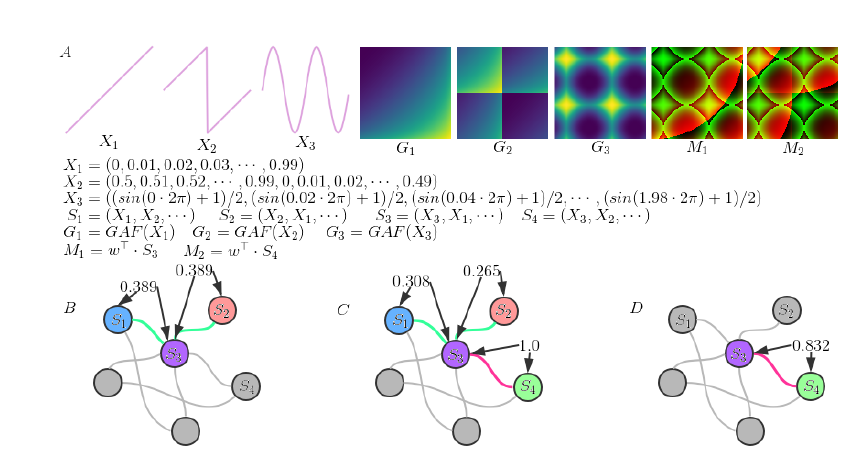
Figure 2. Correlation of time series and images. ( A ) X 1 , X 2 and X 3 represent different time series; G 1 , G 2 and G 3 are GAF images converted from the time series X 1 , X 2 and X 3 , respectively. S 1 is a multivariate time series in which the first element is X 1 and the second element is X 2 . Similarly, S 2 , S 3 and S 4 are multivariate time series, respectively. M 1 and M 2 are MGAF images converted from S 3 and S 4 , respectively. ( B ) Only use the first element of S 1 , S 2 and S 3 . In this situation, the Pearson similarity of S 1 and S 3 is 0.389 and S 2 and S 3 are the same. ( C ) In previous methods, the MSSIM of the corresponding GAF image of S 1 and S 3 was 0.308, and the MSSIM of the corresponding GAF image of S 2 and S 3 was 0.265. The MSSIM of the corresponding GAF image of S 3 and S 4 was 1.0. ( D ) Taking the first and second elements of S 3 and S 4 into consideration, the MSSIM of the corresponding MGAF image of S 3 and S 4 is